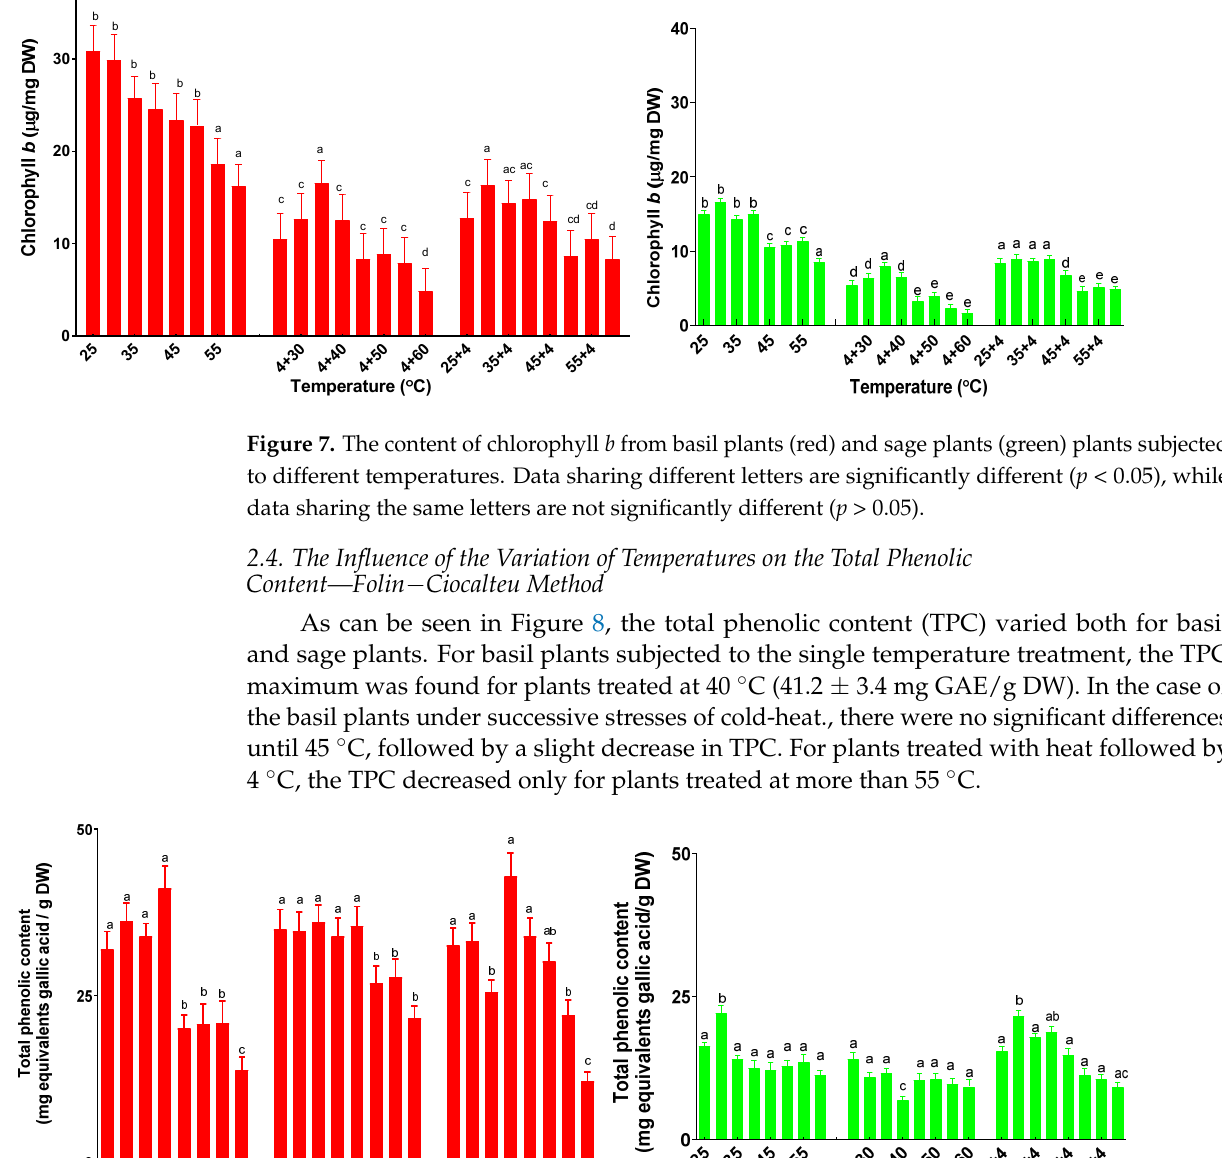
Figure 9. The flavonoid content of basil plants (red) and sage plants (green) plants subjected to dif- ferent temperatures. Data sharing different letters are significantly different ( p < 0.05), while data sharing the same letters are not significantly different ( p > 0.05). In the case of basil plants subjected to the single temperature treatment, the optimum temperature for FC was 35 °C (5.56 ± 0.18 mg rutin equivalents/gDW), and a significant decrease has been found only after 45 °C. The highest amount of FC for plants under the successive coldheat treatment was 3.93  0.16 mg rutin equivalents/gDW at 4 + 40 °C. The